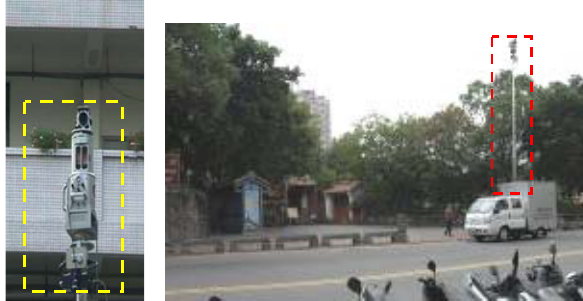
Figure 4.The device raising 3D scanner and working on vehicle